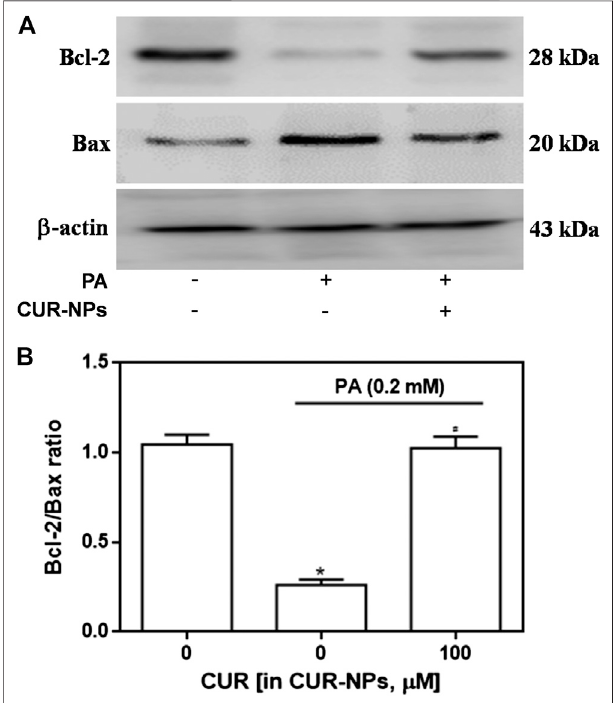
FIGURE 5 | Effects of CUR-NPs on the expression of apoptosis pathway-related proteins in cardiomyocytes exposed to PA (A) Representative images of Bax and Bcl-2 expression by western blot (B) Quantitative analysis of the Bcl-2/Bax ratio. * p < 0.05 vs control group; # p < 0.05 vs PA